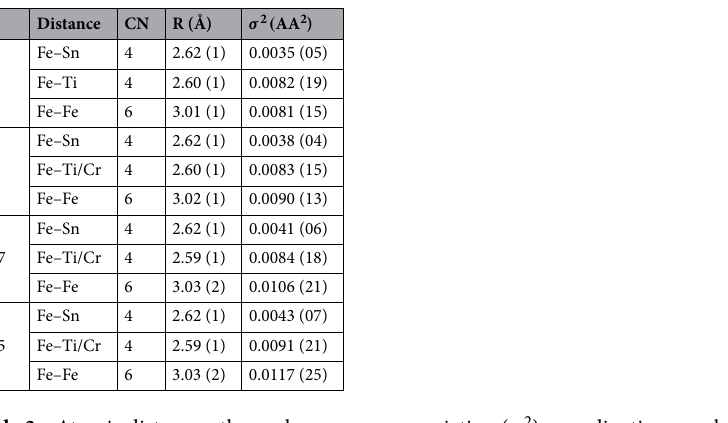
Table 3. Atomic distances, thermal mean square variation ( σ the fitting of EXAFS spectra of Fe 2 Ti 1